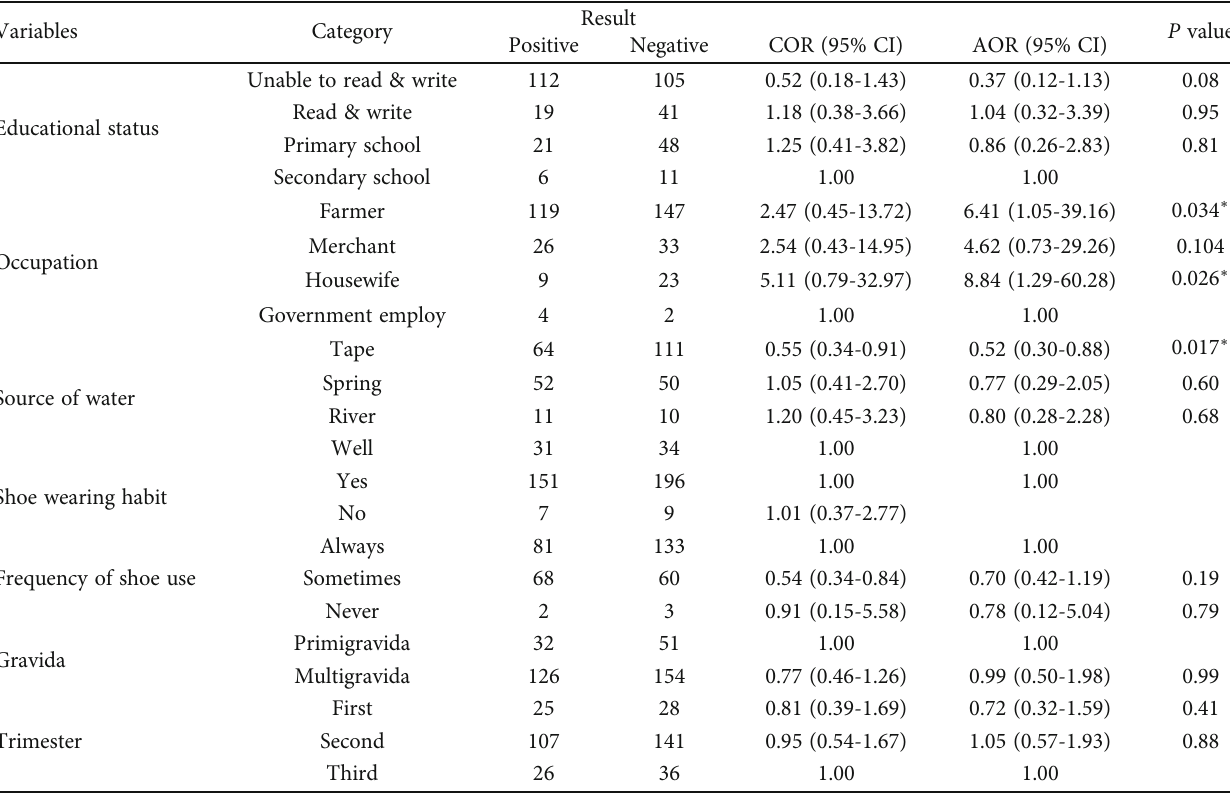
Table 3: Bivariate and multivariate analysis of factors associated with intestinal parasites among pregnant women at Debre Elias district, March 2021 to July